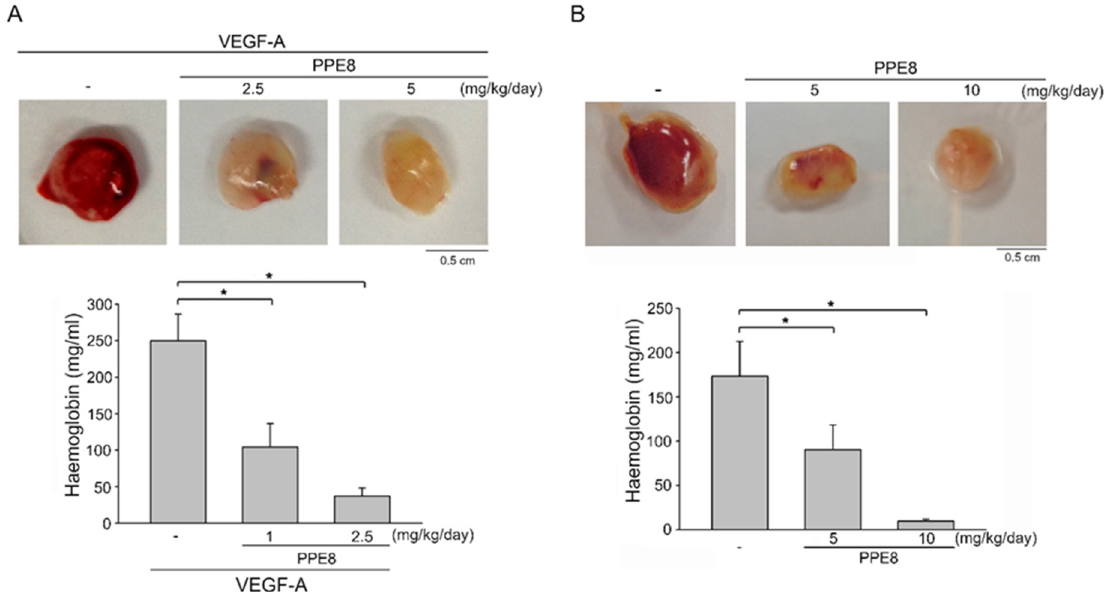
Figure 3. PPE8 reduced VEGF-A- or tumor-cell-elicited angiogenesis ( A ) PPE8’s in vivo effects on VEGF-A-induced angiogenesis were determined using a Matrigel plug assay as described in the “Materials and Methods” section. Matrigel plugs removed from the vehicle- or PPE8-treated mice are shown in the upper panel of the chart. Hemoglobin levels in the Matrigel plugs are shown in the bottom panel of the chart. Each column represents the mean ± S.E.M. of six plugs. * p < 0.05, compared with the group treated with VEGF-A alone; one-way ANOVA, with Tukey’s post hoc test. ( B ) PPE8’s in vivo effects on MDA-MB-231-breast-cancer-cell-induced angiogenesis was determined using a tumor-cell-induced angiogenesis Matrigel plug assay as described in the “Materials and Methods” section. Matrigel plugs removed from the vehicle- or PPE8-treated mice are shown in the upper panel of the chart. Hemoglobin levels in the Matrigel plugs are shown in the bottom panel of the chart. Each column represents the mean ± S.E.M. of six plugs. * p < 0.05, compared with the group treated with VEGF-A alone; one-way ANOVA, with Tukey’s post hoc test.